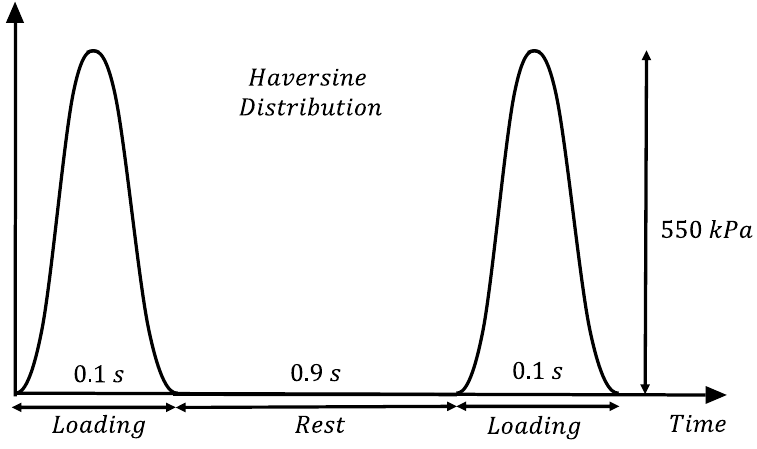
Figure 4. Haversine distribution of vehicular loading.